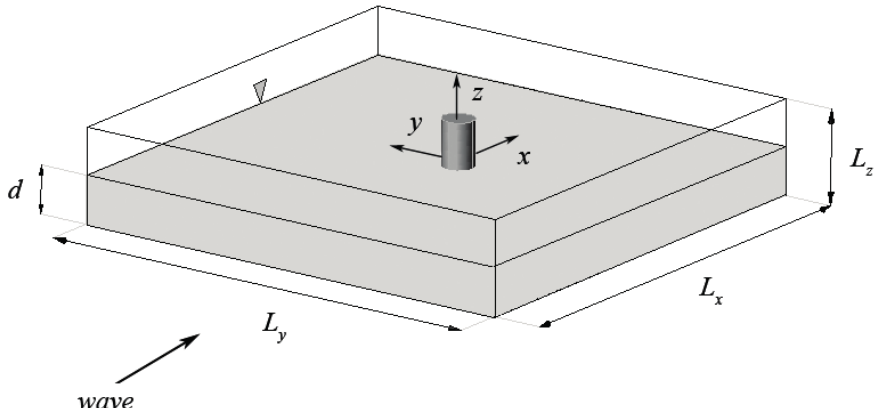
Figure 3. The computing domain (all wave-flow